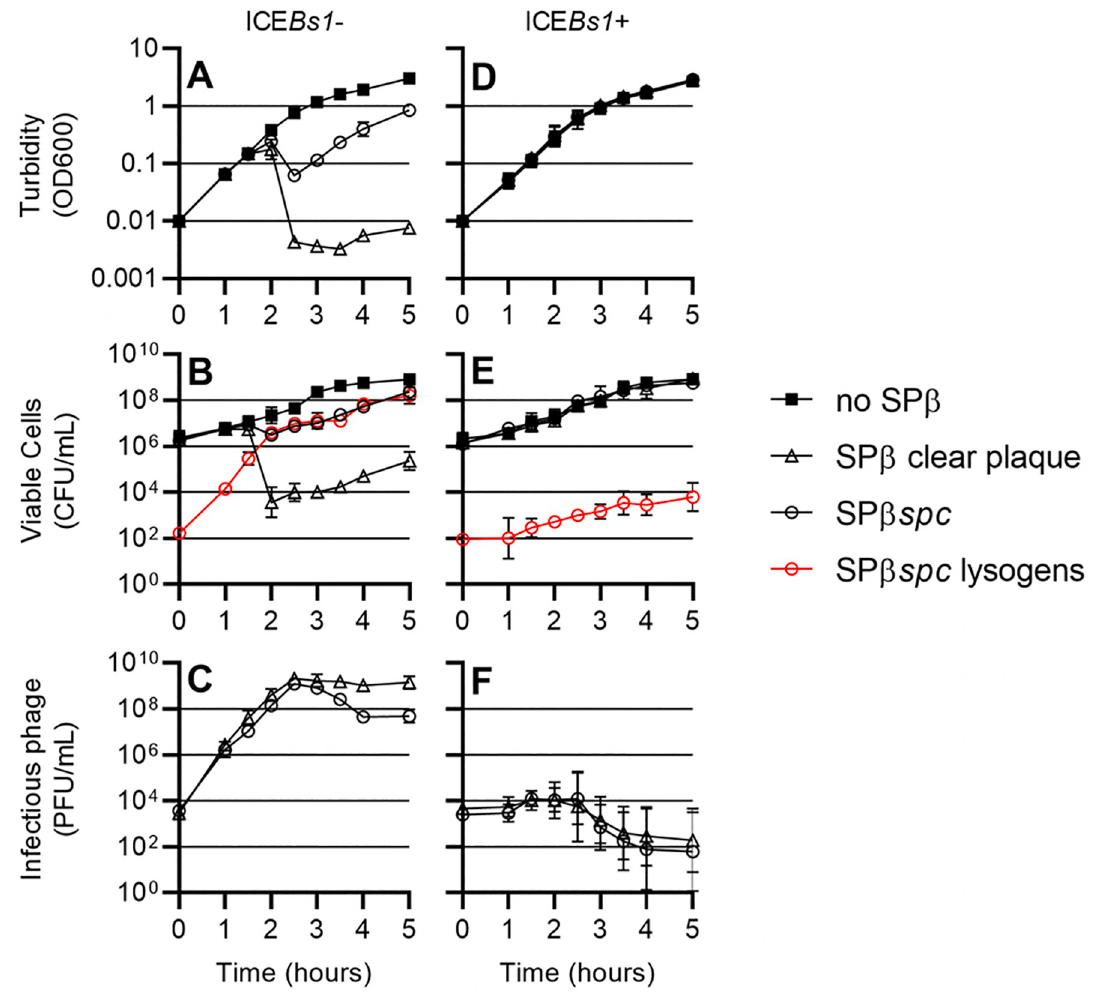
Fig 7. ICE Bs1 protects B . subtilis populations against SPß. A, B, C, SPß 0 ICE Bs1 0 (CU1050) and D, E, F, SPß 0 ICE Bs1+ (CMJ81) were grown in rich medium, infected with no phage (filled squares), SPß clear plaque (open triangles), or SPß:: spc (open circles) at an MOI of approximately 1:100 and diluted in fresh medium to an OD600 of 0.01. Culture turbidity ( A, D ), CFUs/ml ( B, E) , and the number of infectious phage per ml of culture ( C, D ) were tracked over time. Additionally, for cultures infected with SPß:: spc , the number of lysogenized cells were tracked over time (red open